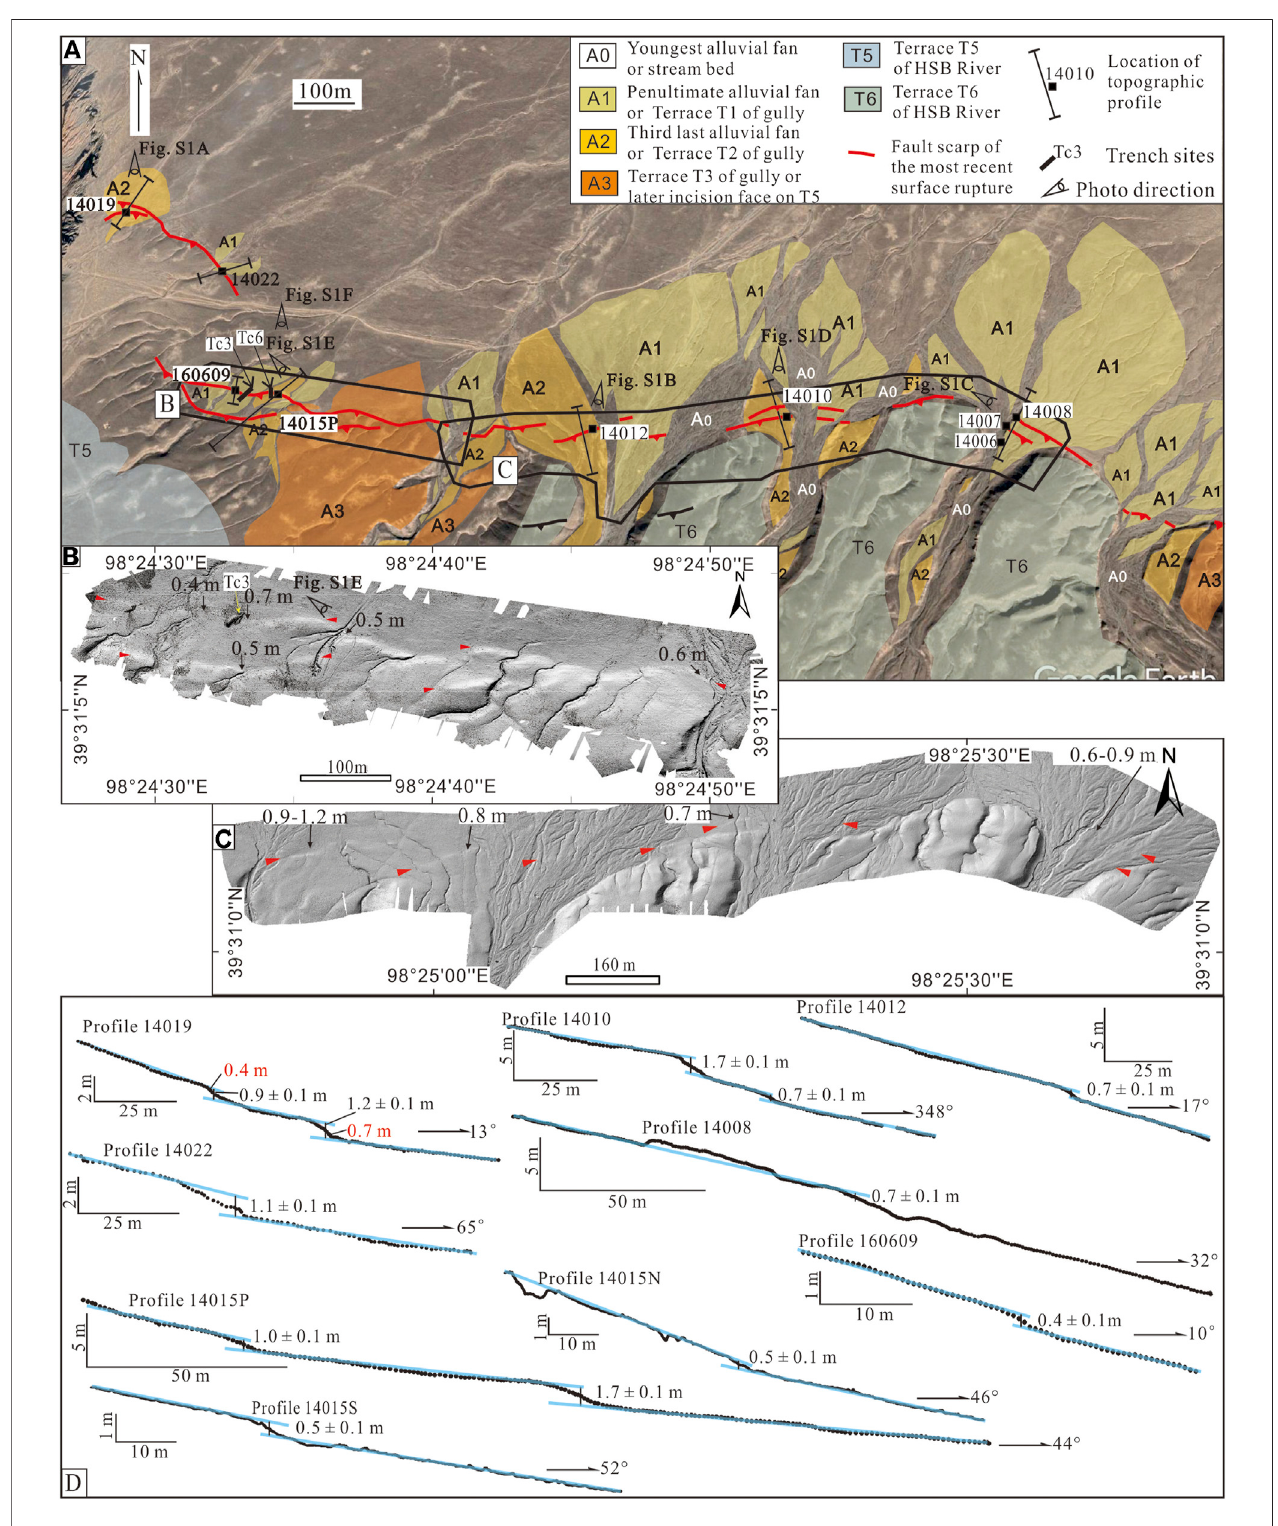
FIGURE 4 | Topographic features of the 1609 earthquake surface rupture on the Hongshuiba River site. (A) Surface rupture map. (B,C) Hillshade DEM extracted from UAV aerial photography along the eastern section. (D) Topographic pro fi les across portions of 1609 rupture traces.